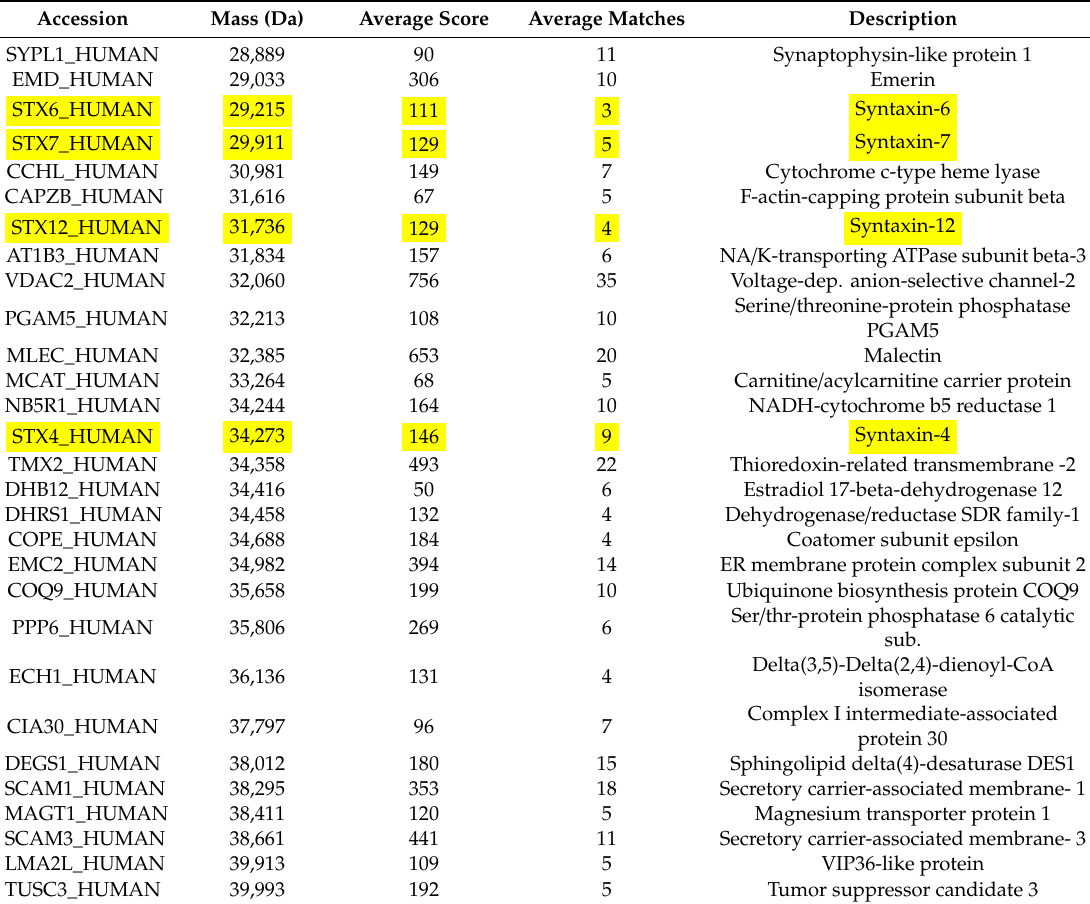
Table 1. PTS partners list (synthaxins highlighted in yellow) including Mascot scores and matches (average values from two